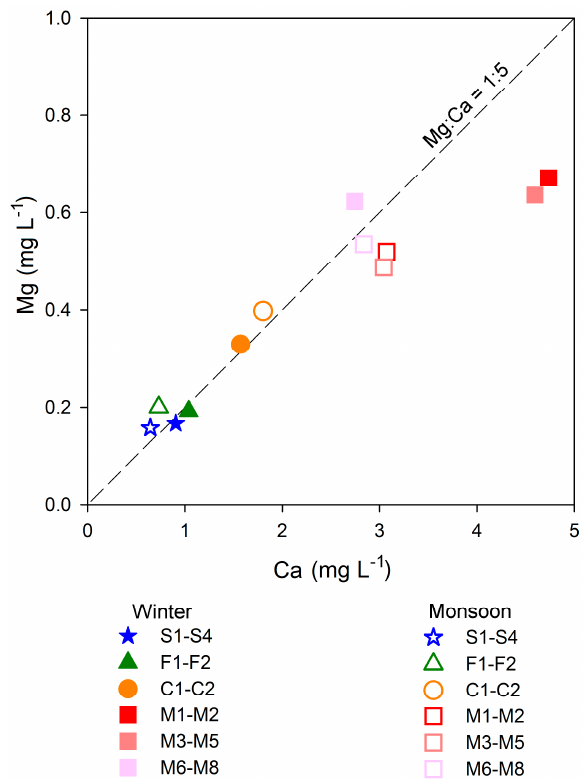
Figure 3. Comparison of Mg versus Ca concentrations for the Umiew and Nongkrem nested catchments system.